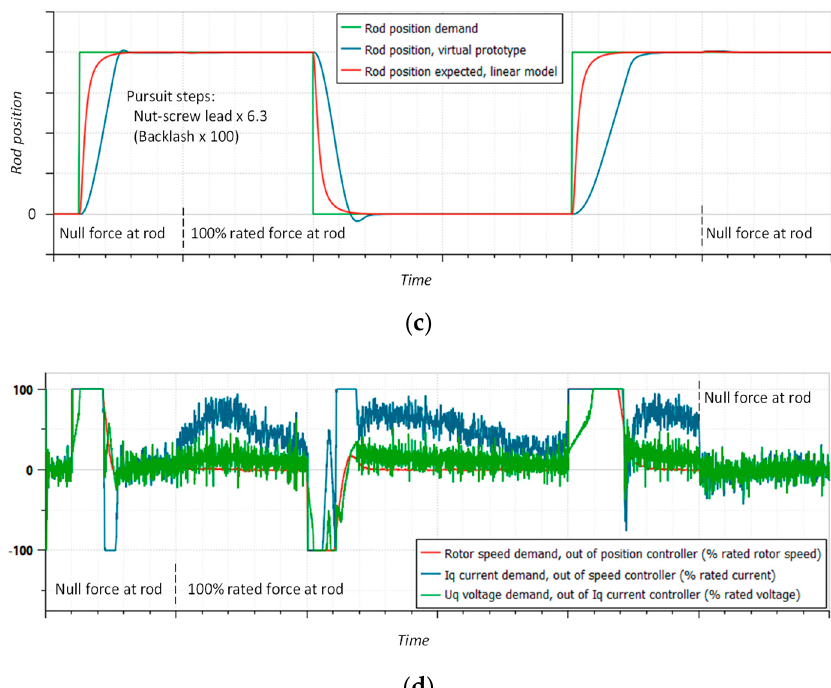
Figure 10. Time response of the position loop for step excitations: ( a ) small-magnitude excitations, noise effects magnified; ( b ) rejection of rod force disturbance, null position demand; ( c ) large-magnitude excitations, introducing long saturation of the current and modulation ratio; and ( d ) controller outputs for large-magnitude excitations.